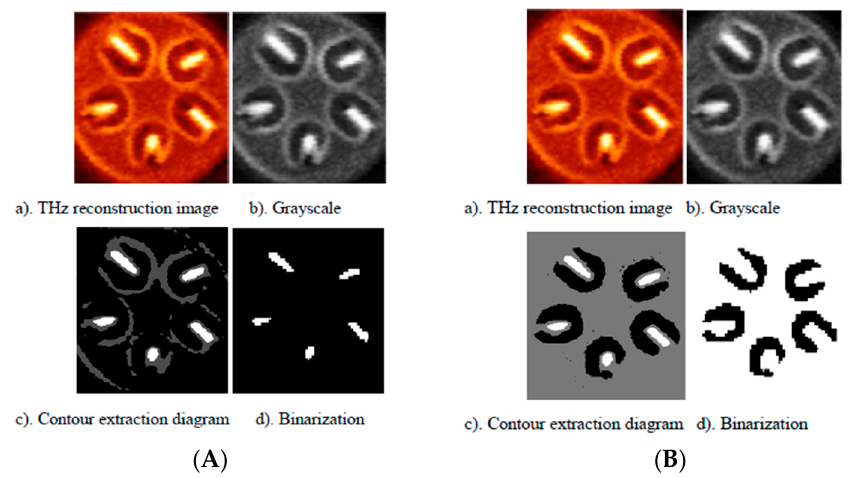
Figure 4. ( A ) Embryo region location extraction process; ( B ) endosperm region location extraction process. (Reprinted/Adapted) with permission from [83] © 2016, IFAC Hosting by Elsevier Ltd.